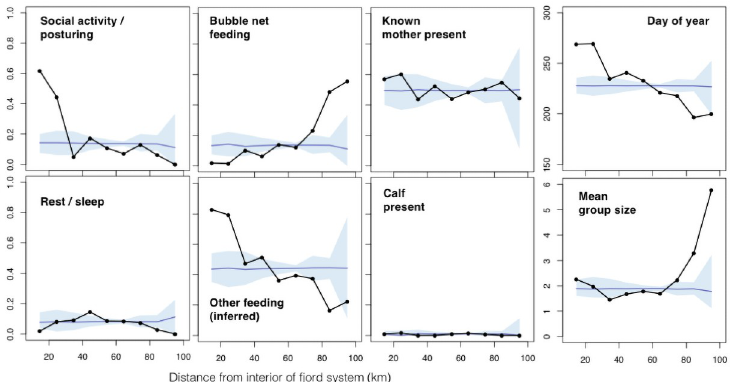
Fig 3. Geographic patterns in the behavior, seasonality, and habitat use of humpback whales within the Kitimat Fjord System. In each pane, the black line indicates the frequency of each variable of interest, pooled into bins of swimming distance from the interior of the fjord system (bin size = 10km, 0–100 km. Blue shaded area represents the frequency expected by random chance, determined via randomization (1,000 iterations; blue line = median; shading = 95% confidence interval, determined using 0.025 and 0.975